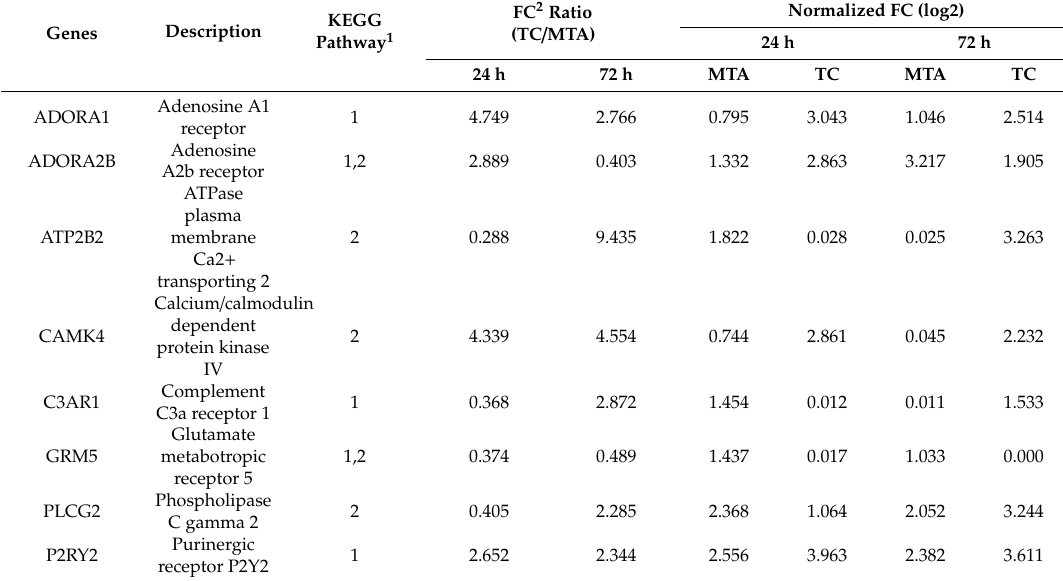
Table 3. Summary of DEGs in KEGG pathway involved in TC for 24 h and 72 h.